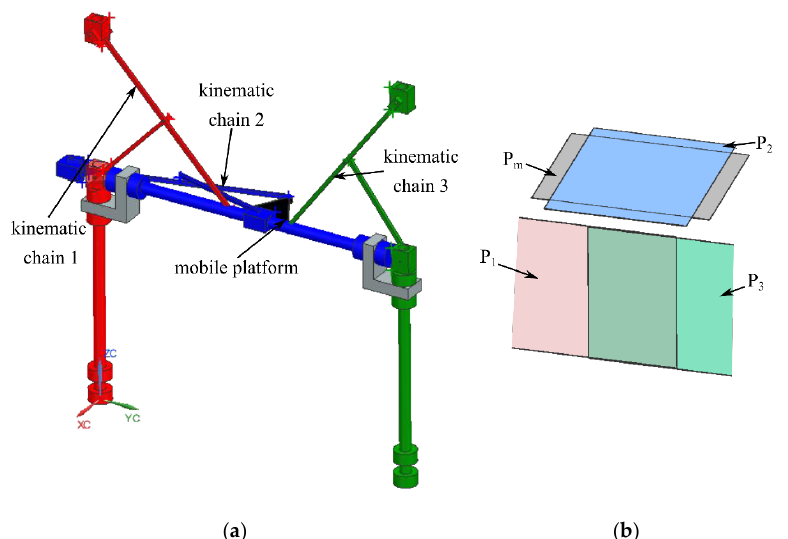
Figure 12. Type II singularity of the 6-DOF parallel robot for SILS (case 7 — one face and the base of the characteristic tetrahedron are coplanar and the other two faces of the tetrahedron are also co- planar): ( a ) parallel robot pose; ( b ) characteristic planes.